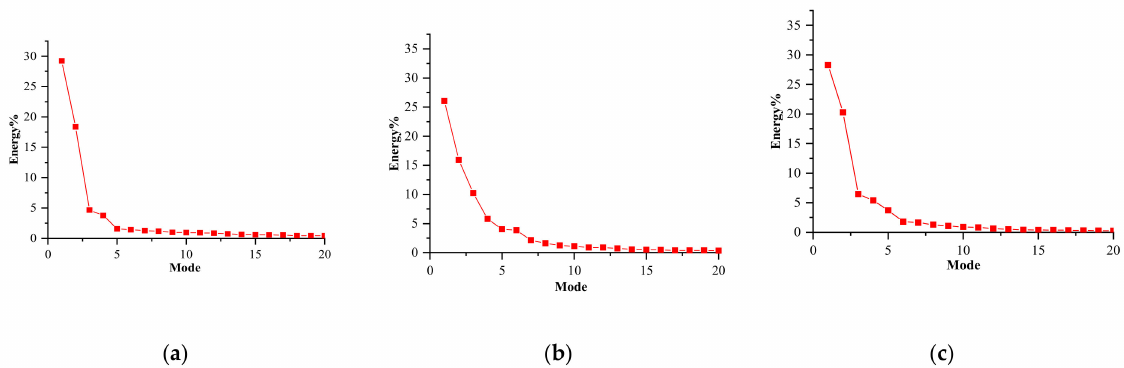
Figure 13. POD distribution of energy for 20 modes of the fully confined case at ( a ) Re = 2680, ( b ) Re = 6440, and ( c ) Re = 10,730.